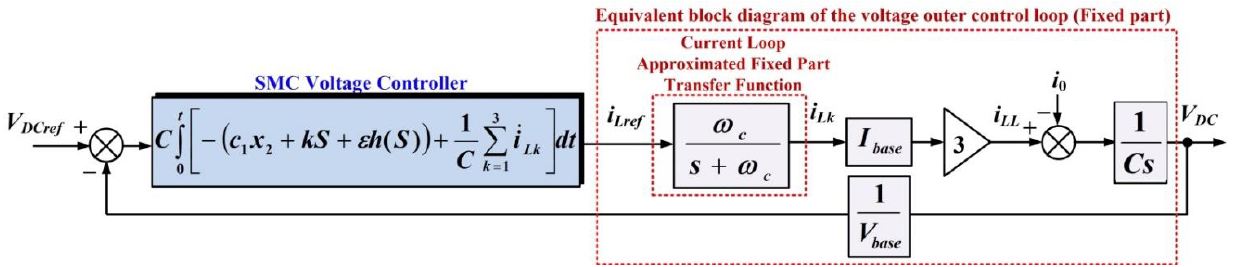
Figure 8. Block diagram modeled using the transfer function for the control system of the power electronic converter using an SMC controller for the voltage outer control